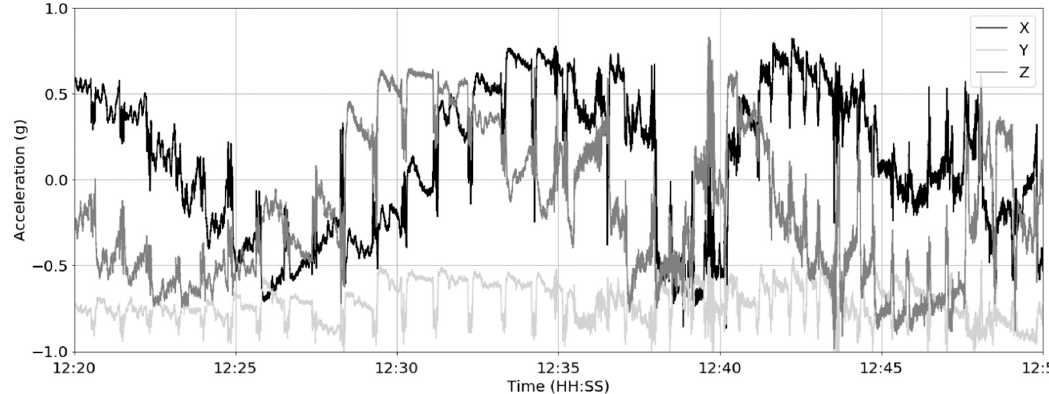
Figure 4. The x, y and z bolus acceleration for a 30 min period from cow #2.